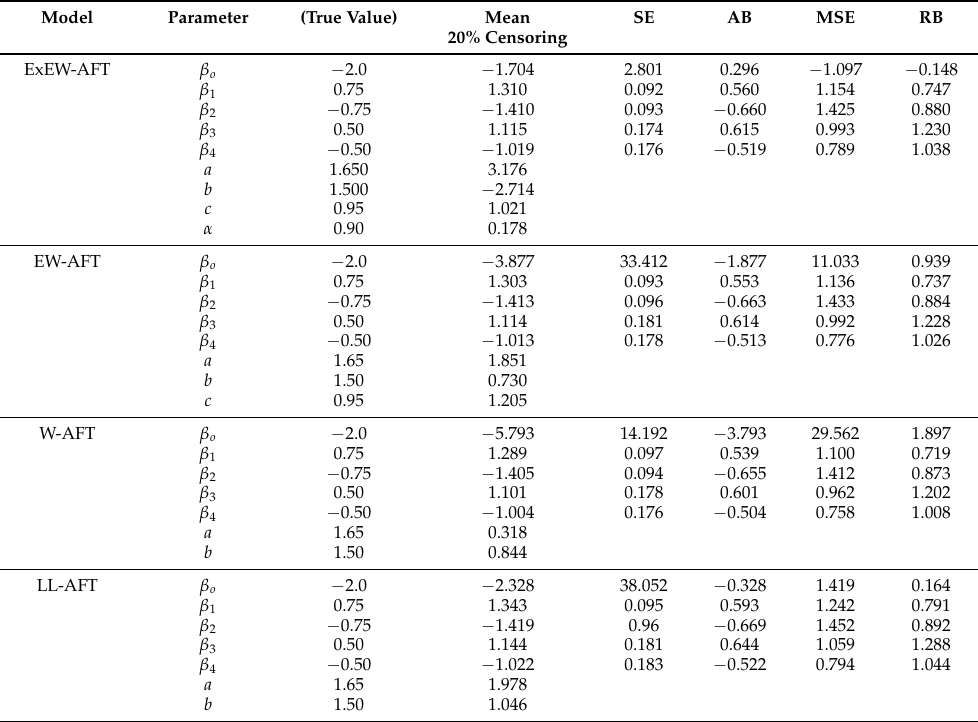
Table 13. Simulation study for scenario 4 ( n = 1000) with about 20% censored observations is used to compare model performance.